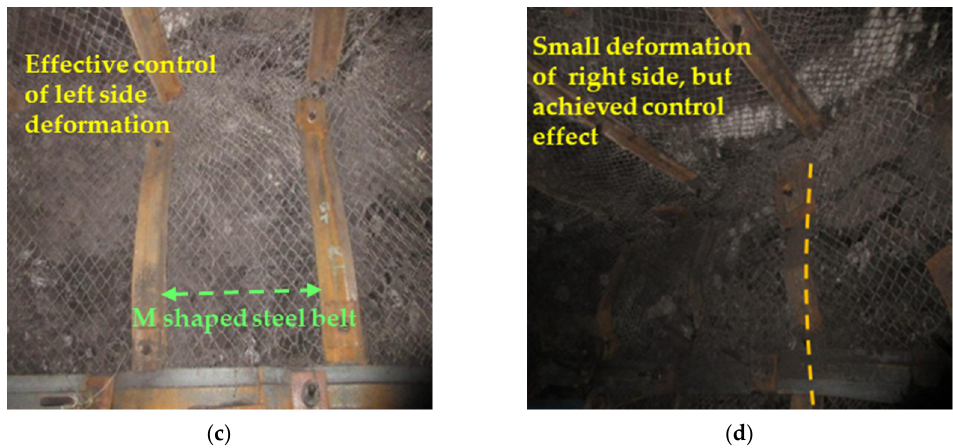
Figure 22. Application effect of the full-stress anchoring plan of bolts. ( a ) Roof control effect; ( b ) side-angle control effect; ( c ) left-side control effect; ( d ) right-side control effect.